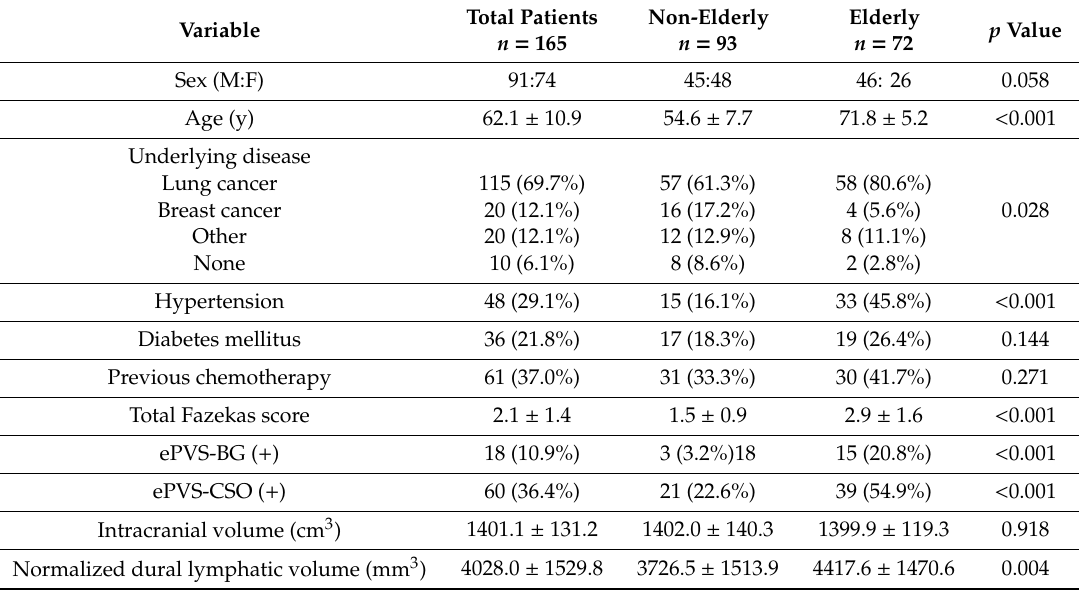
Table 1. Patient characteristics and comparisons of demographics in study population according to age.